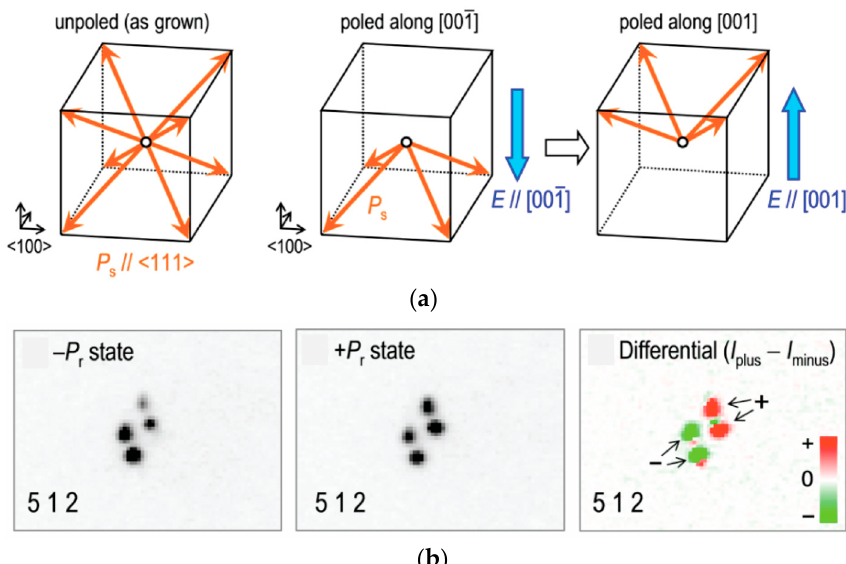
Figure 11. ( a ) The eight equivalent directions for polarization vector P s in rhombohedral Na 0.5 Bi 0.5 TiO 3 and their preferred states under applied electric fields. ( b ) Changes in scattering intensities of the symmetry related diffraction spots coming from domain variants with polarization directions as indicated in the top panel. A non-equivalence of the diffraction spots for electric fields applied parallel to 100 and 001 indicates non-180° domain reorientation processes for polarization switching. After Kitanaka et al. [84]. Reprinted from reference [85] DOI: 10.1103/PhysRevB.89.104104, with permission from the American Physical Society.